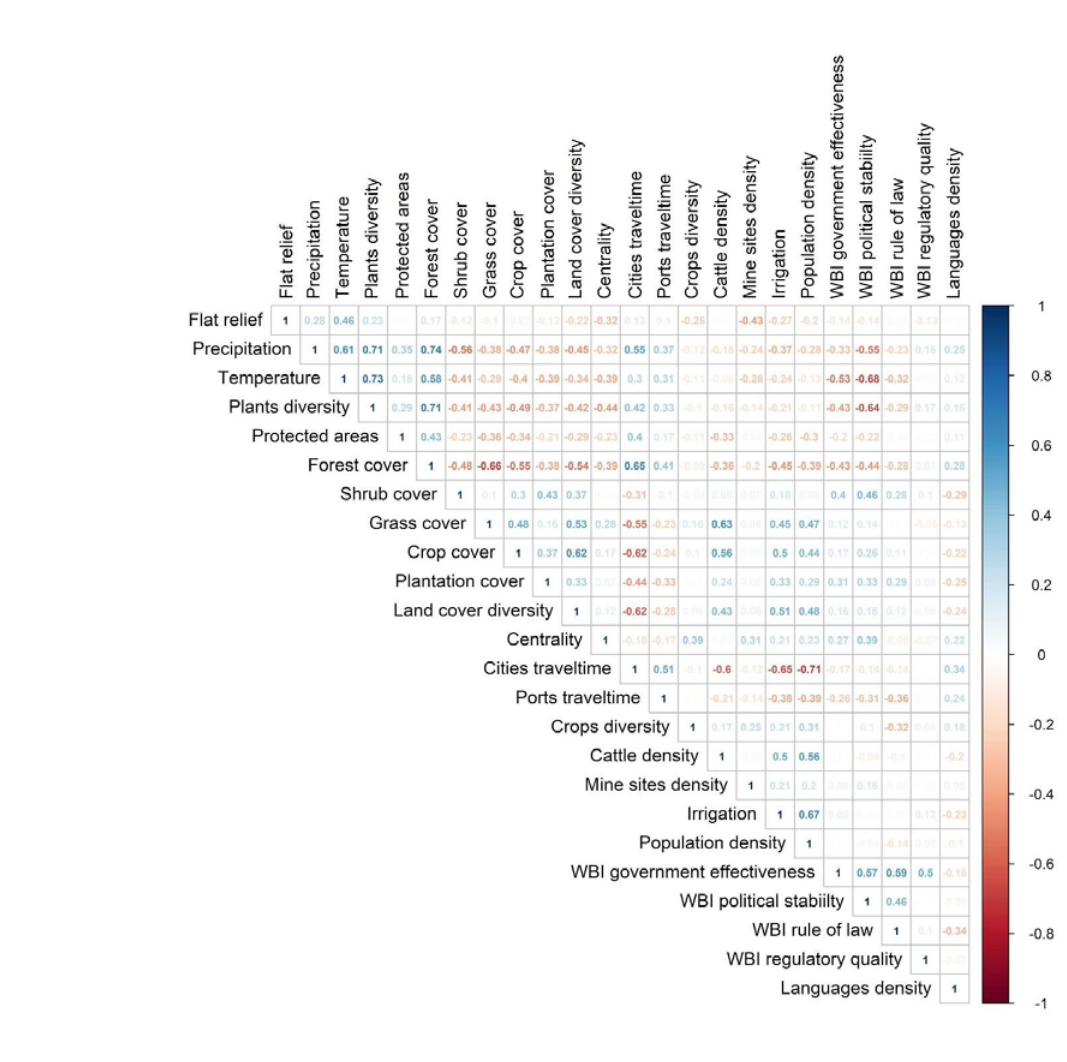
Figure A1.2 . Variables correlation matrix. Spearman correlation between all 24 numeric variables considered for the analysis. Positive correlations are in blue, negative correlations are in red, and the strength of the color reflects the strength of the correlation (white color corresponds to correlation coefficients close to zero, therefore not relevant for this